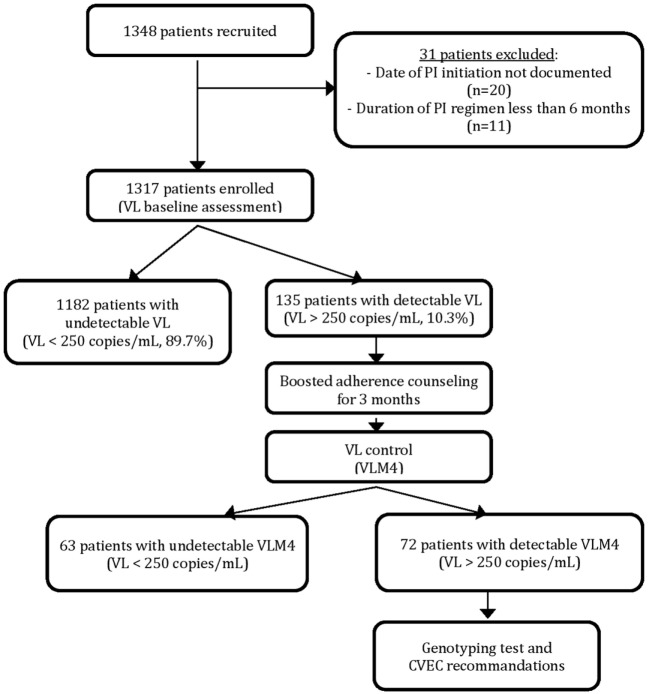
Patient enrolement and virological assessment.